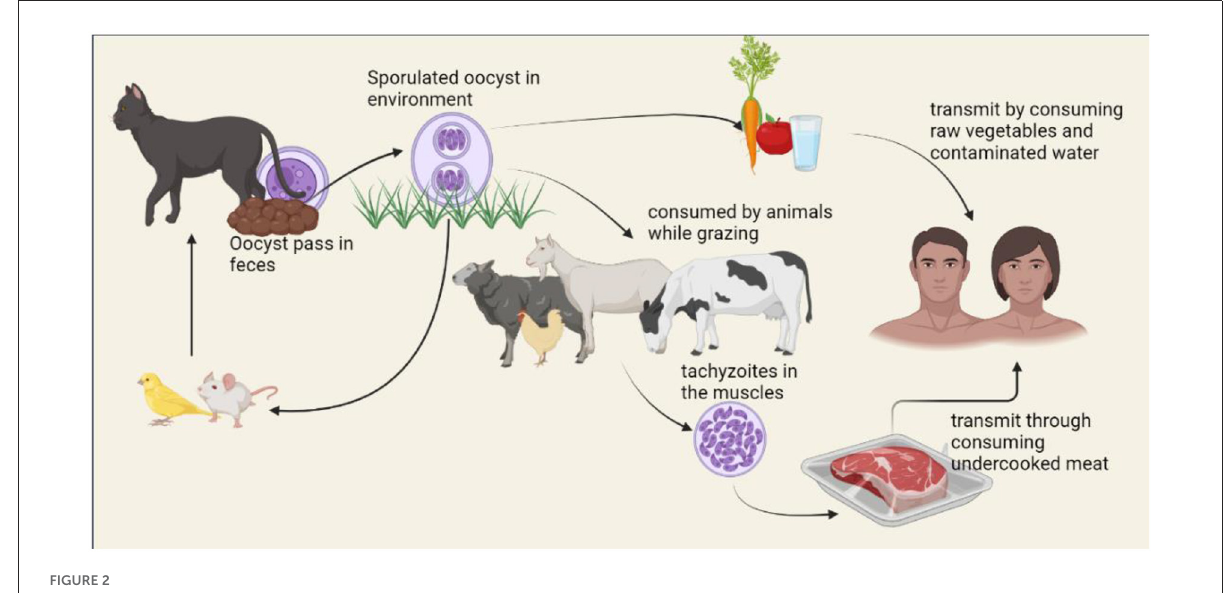
FIGURE2 Life cycle of Toxoplasma gondii